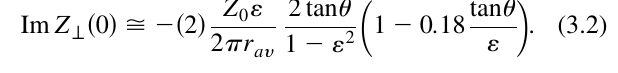
FIG. 3. (Color) Zero-frequency transverse impedance from ABCI (symbols), Yokoya formula Eq. (3.1) (dot-dashed), Eq. (3.2) (dashed), Eq. (3.3)